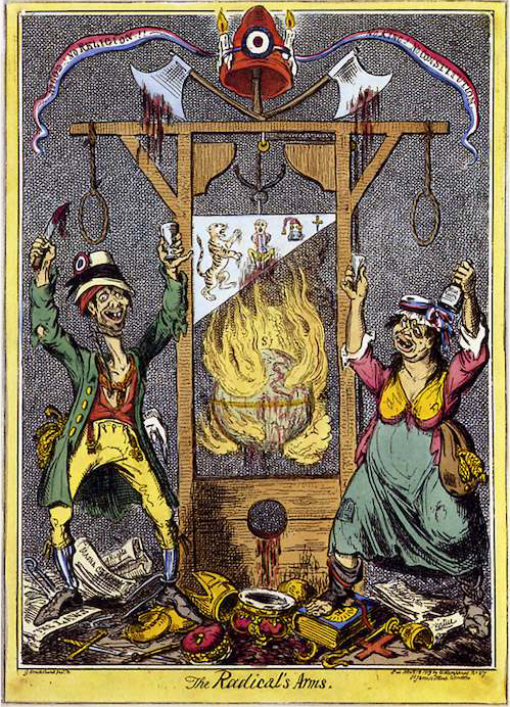
Figure 1. George Cruickshank, The Radical’s Arms (1819)